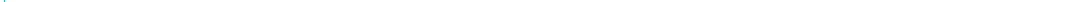
Figure 1: IL-2 complexes stimulate potent antitumour CD8 + T cell responses . (A–B) IL-2 activates CD25 high CD4 + Treg and CD122 high CD8 + T cells, whereas CD122-biased IL-2 complexes (such as IL-2/NARA1 complexes) preferentially stimulate CD122 high CD8 + T cells. (C) NARA1 binds with 10-fold higher affinity than CD25 to the CD25 epitope of IL-2. (D–F) IL-2/NARA1 complexes elicit potent antitumour re- sponses in Tyr::N-Ras Q61K Ink4a –/– mice (that spontaneously develop melanoma; ref [29]) (D) as well as in the cutaneous (E) and pulmonary B16F10 mouse melanoma models (F). Adapted from refs [12, 21].